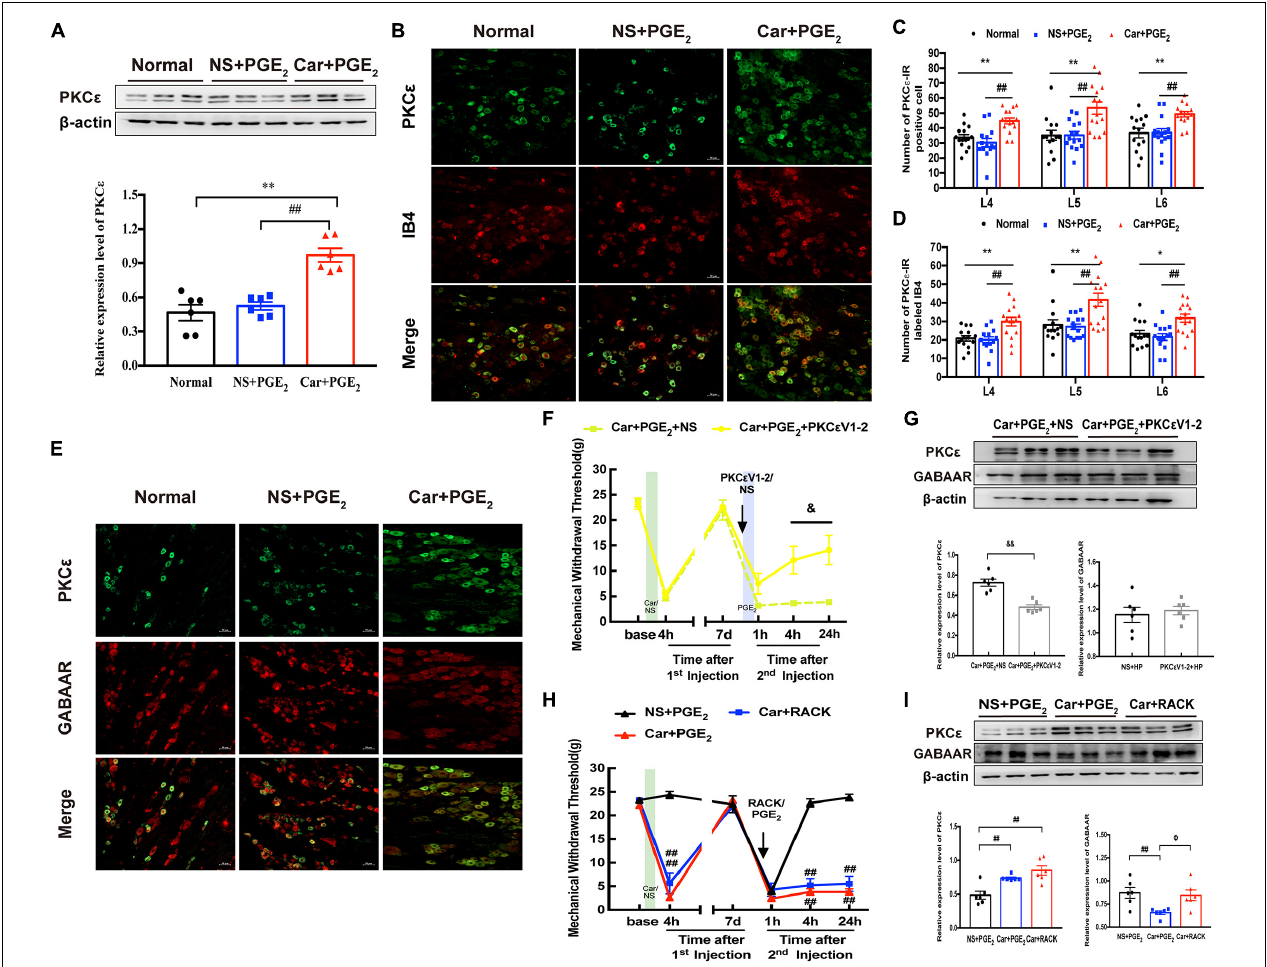
FIGURE 3 | PKC ε contributes to the pain transition, but not regulates GABAAR expression. (A) The quantification of the Western blots results and a representative Western blot showing PKC ε protein isolated from the DRG 24 h after 2nd injection. (B) Representative images of PKC ε -IR positive neurons (green) merged with IB4 neurons (red) in lumbar DRG of hyperalgesic priming rats. (C) The quantification of PKC ε -IR positive neurons in L4, L5, and L6 DRG, respectively. (D) The quantification of PKC ε -IR positive neurons labeled with IB4 in L4, L5, and L6 DRG, respectively. 15 sections from three different rats. (E) Representative images of PKC ε -IR positive neurons (green) merged with GABAAR-IR positive neurons (red) in lumbar DRG of hyperalgesic priming rats. (F) MWT of hyperalgesic priming rats that received PKC ε V1-2 (1 µ g/25 µ L/paw) injection 10 min before the PGE 2 injection. n = 6. (G) The quantification of the Western blots results and a representative Western blot showing PKC ε and GABAAR protein isolated from the L4-L6 DRG 24 h after 2nd injection. (H) MWT of rats that received ψε RACK (1 µ g/25 µ L/paw) injection following by carrageenan. n = 6. (I) The quantification of the Western blots results and a representative Western blot showing PKC ε and GABAAR protein isolated from the L4-L6 DRG 24 h after 2nd injection. Data are presented as mean ± SEM, n = 6; * P < 0.05, ** P < 0.01 vs. Normal group, ## P < 0.01 vs. NS + PGE 2 group. & P < 0.05, && P < 0.01 vs. Car + PGE 2 + NS group, (cid:56) P < 0.05 vs. Car + PGE 2 group. Student’s t -test was used to compare two independent samples; Three independent samples are according to ANOVA followed by Bonferroni post hoc